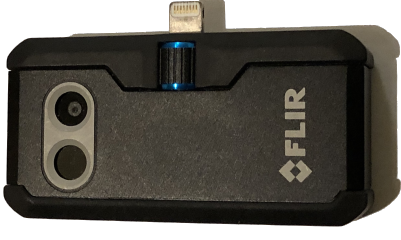
Figure 1. FLIR ONE PRO camera.